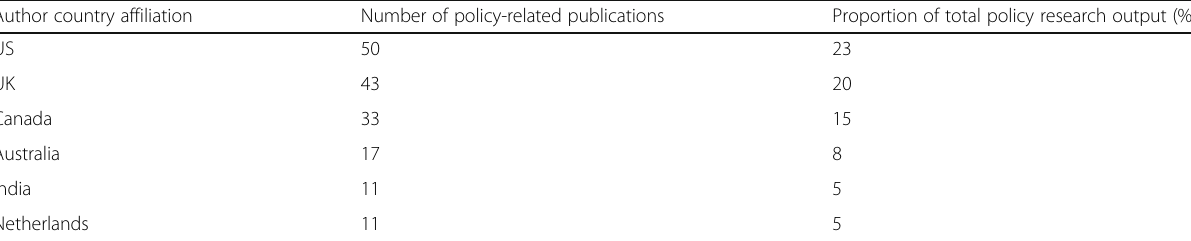
Table 1 Country affiliation of authors publishing most policy-related research on medical tourism (selected list)